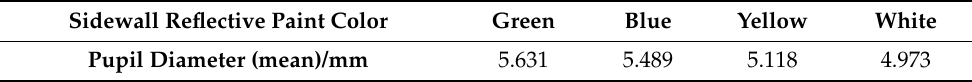
Table 10. Table of influence degree of the side wall reflective paint color and pupil diameter.